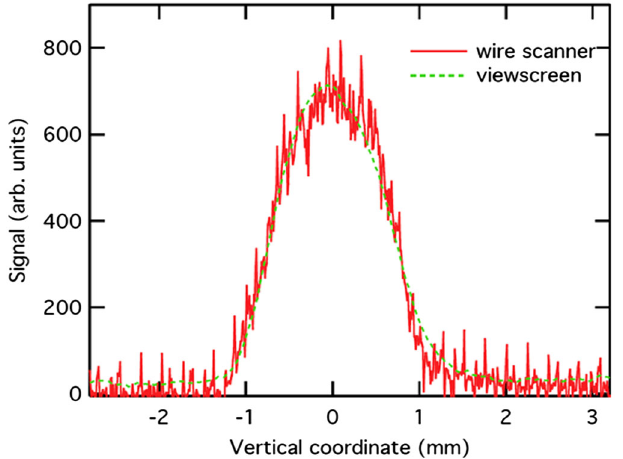
FIG. 13 (color online). Comparison of the beam profile obtained with the wire scanner (solid line) and the luminescent viewscreen (broken line) for 20 μ A average beam current (0.015 pc bunch